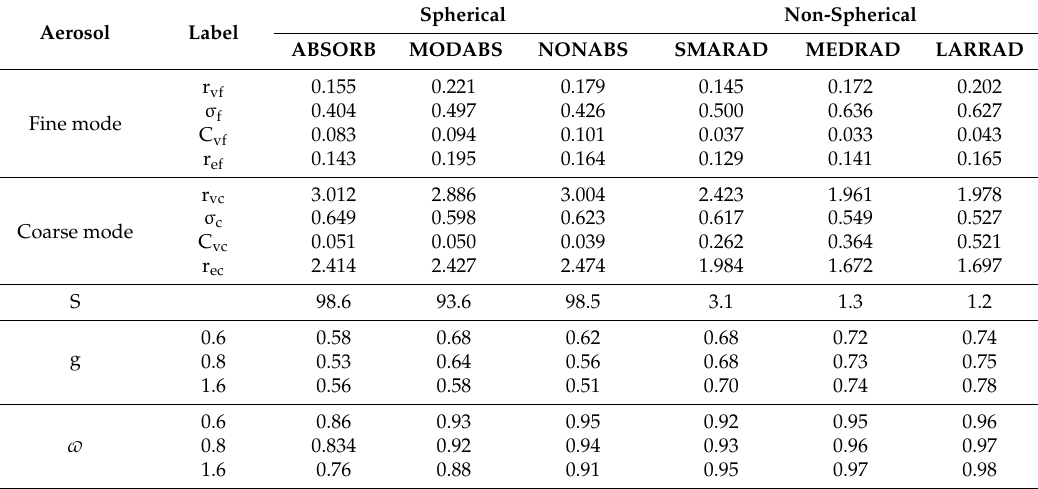
Table 2. Properties of the spherical and non-spherical aerosol model in solar band of MSG/SEVIRI derived from AERONET